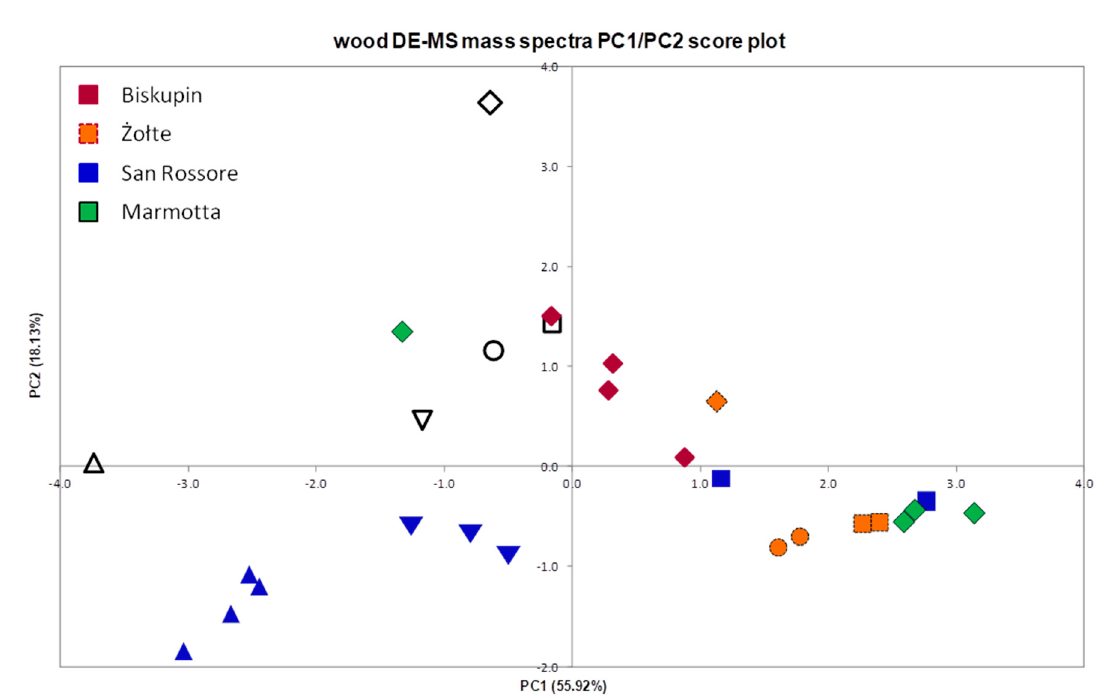
Figure 2. PCA (principal component analysis) score plot of the DE-MS mass spectral data obtained from reference and archaeological wood samples collected from the four archaeological sites in Italy and Poland. Sound wood: -oak, -beech, -alder, -elm, -pine; Archaeological wood: -oak, -beech, -alder, -elm, -pine.